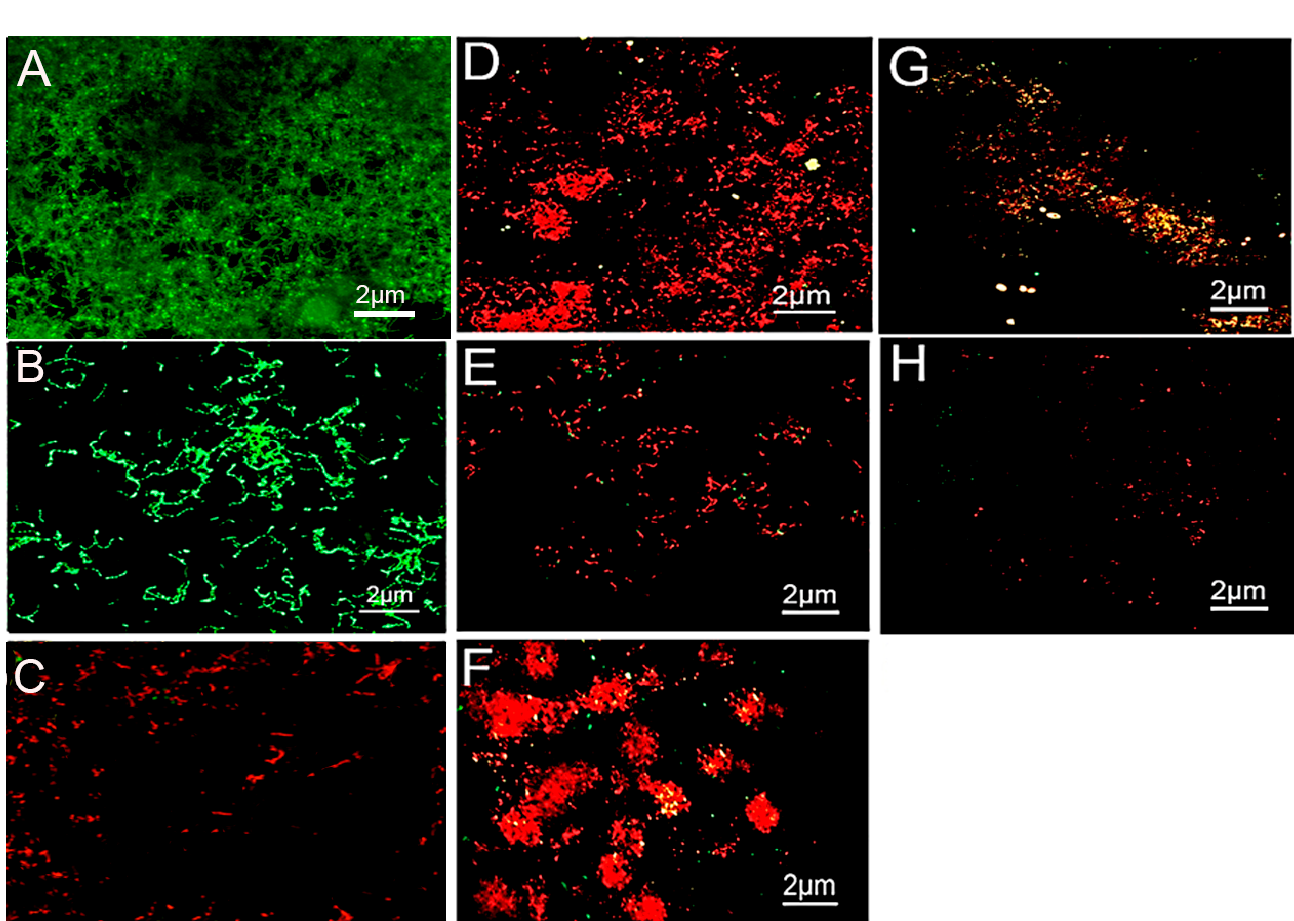
Figure 1. Representative CLSM images of ( A ) S. mutans and ( B ) S. sanguinis grown on enamel discs for 7-days with 0.9% NaCl treatment. ( C ) 1% arg-treated enamel specimens with S. mutans . ( D ) 2% arg-treated enamel specimens with S. mutans . ( E ) 1% arg-treated specimens with S. sanguinis; and ( F ) 2% arg-treated specimens with S. sanguinis . ( G ) 4% arg-treated S. mutans; and ( H ) S. sanguinis specimens. Table 1 . Bacterial live/dead proportions in mono-species biofilms treated for 7-days . Groups Live (%)–Mean (SD) Dead (%)–Mean (SD) Calculation of Percent Difference